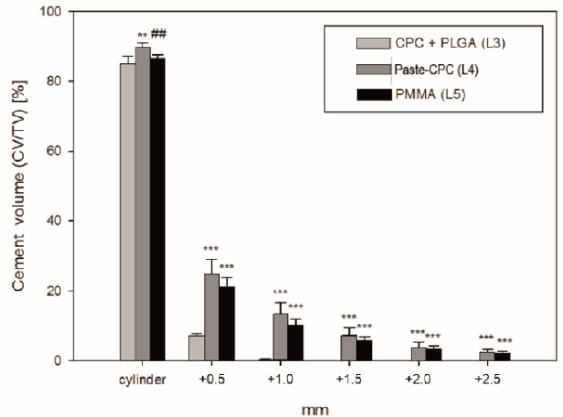
Figure 3. Quantitative analysis of micro-computed tomography pictures of vertebral bodies ex vivo injected with different cements; ** p ≤ 0.01, or *** p ≤ 0.001 versus CPC + PLGA (L3); ## p ≤ 0.01 versus Paste-CPC (L4); CPC, calcium phosphate cement; PLGA, poly(L-lactide-co-glycolide); PMMA, polymethylmethacrylate.